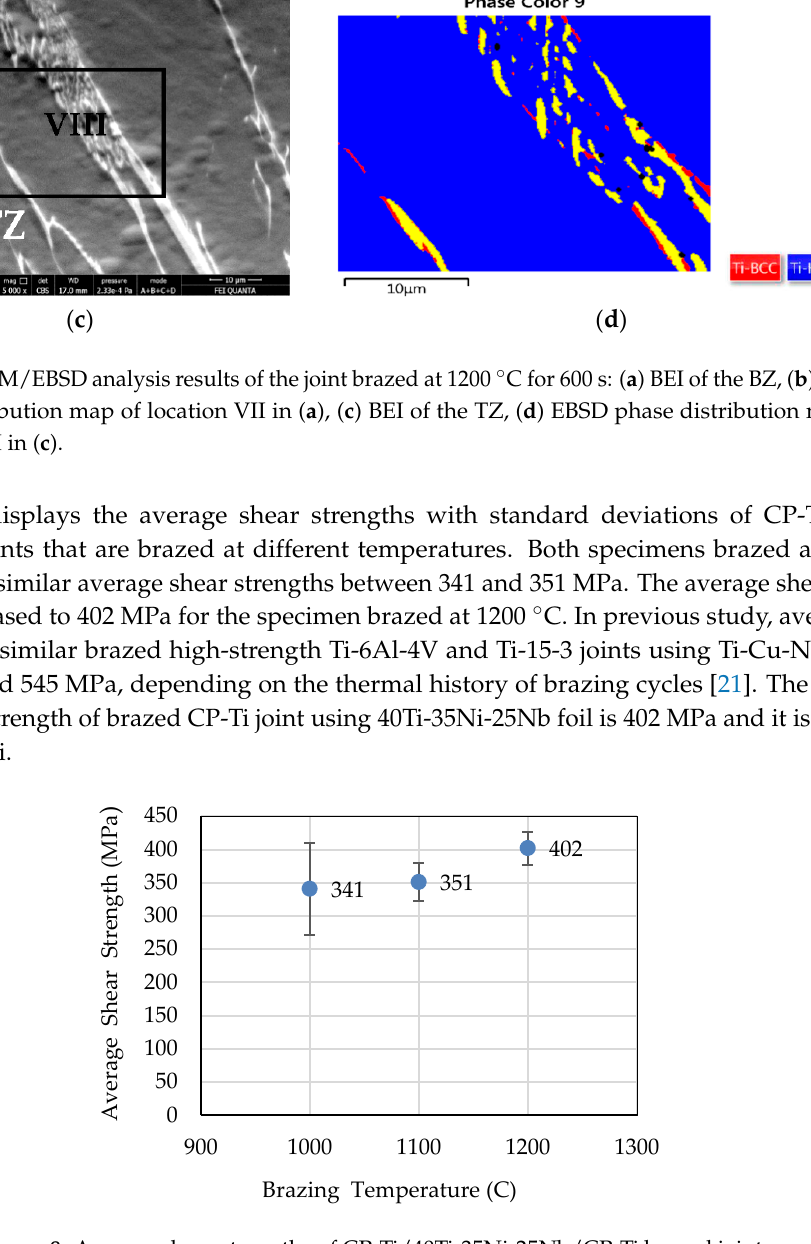
Figure 8. Average shear strengths of CP-Ti/40Ti-35Ni-25Nb/CP-Ti brazed joints.